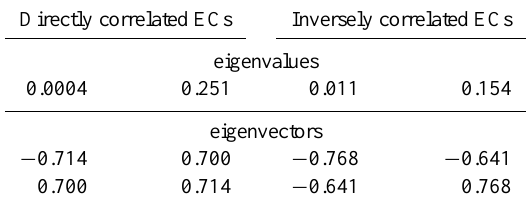
Table A2. Eigenvalues and eigenvectors, left: case 1; right: case 2. Directly correlated ECs